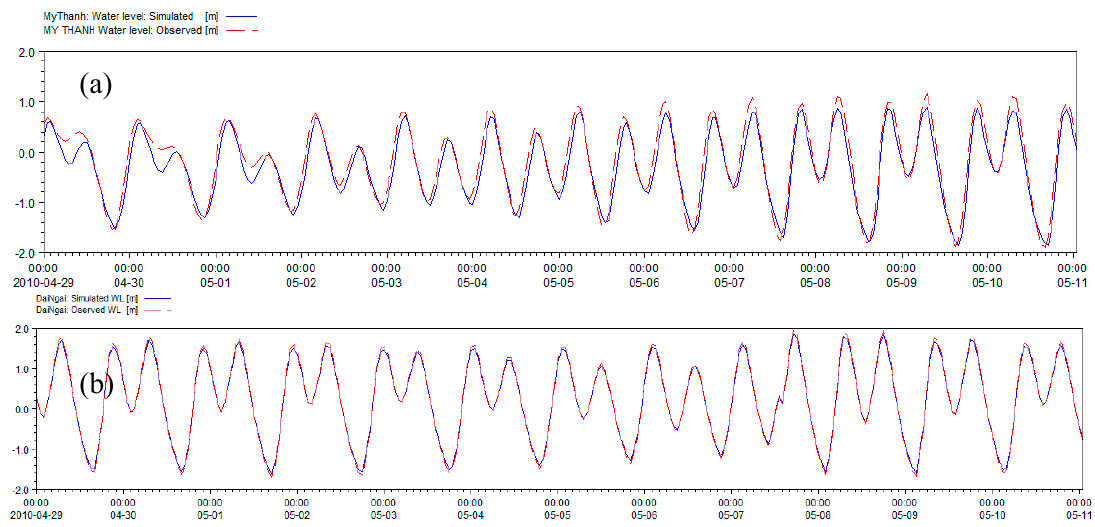
Figure 7. Validation of water level at My Thanh ( a ) and Dai Ngai ( b ) stations.